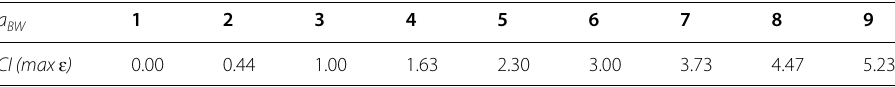
Table 2 Consistency